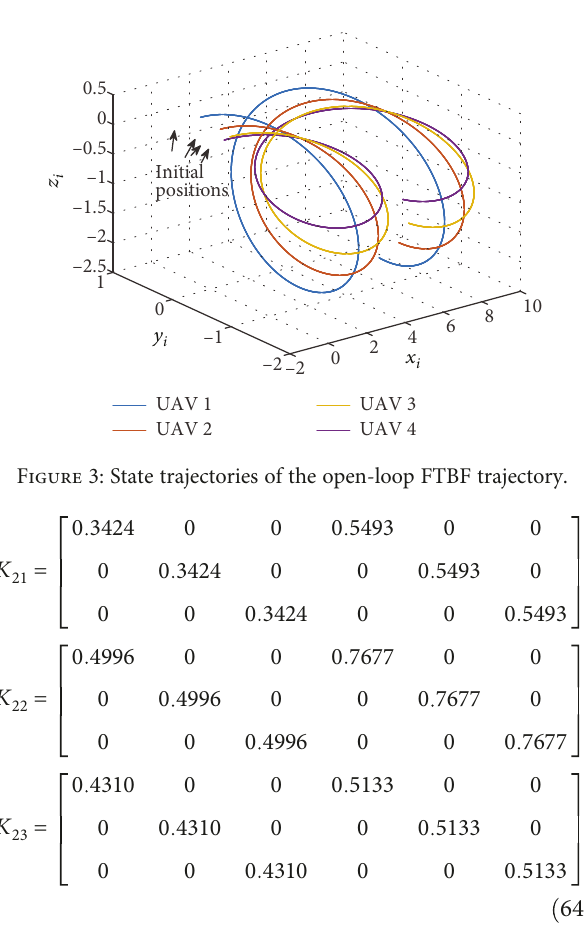
Figure 2: State trajectories of desired time-varying formation.